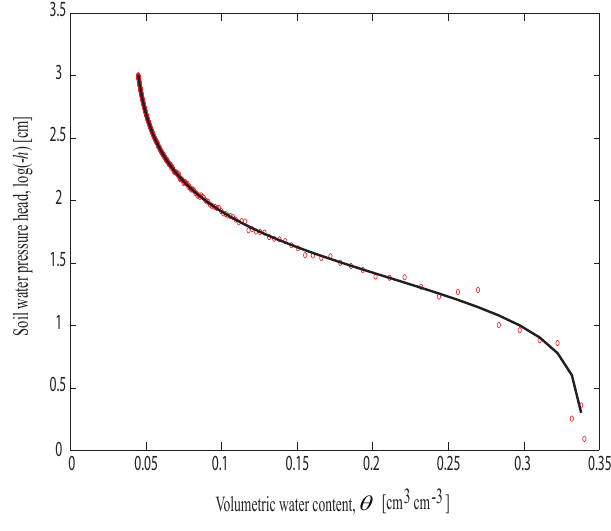
Fig. 5. Synthetic soil water retention curve of the sandy soil, and the effect of data